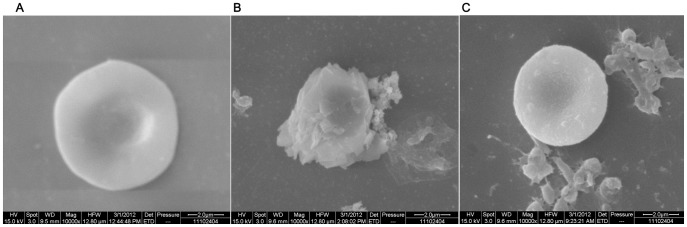
Scanning electron microscope observation of interaction between erythrocytes and H. pylori NCTC11637 strain.(A) The normal erythrocytes have biconcave disc shapes with smooth surfaces. (B) There are more H. pylori colonies closely attached to type A erythrocytes than to other erythrocytes after 4 hours of co-cultivation. The deformation of type A erythrocytes was more pronounced than that of type O erythrocytes. (C) Fewer H. pylori were attached to type O erythrocytes than to type A erythrocytes. Type O erythrocytes retained their original shapes. Only small protrusions appear on the surfaces of type O erythrocytes (10,000×).